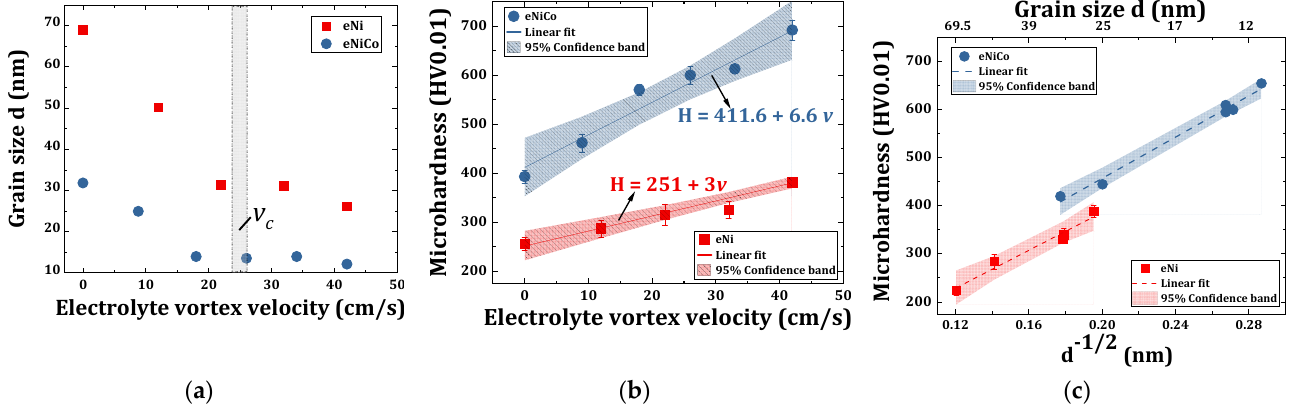
Figure 10. ( a ) Grain size computed from the predominant peaks from XRD diffractograms using the Debye–Scherrer relation for eNi and eNiCo alloy coating samples as a function of BHD; ( b ) Measured microhardness as the function of electrolyte velocity; and ( c ) Measured microhardness as the function of inverse square root function of the grain size, which fits well with the Hall–Petch relationship for eNi and eNiCo alloy coating